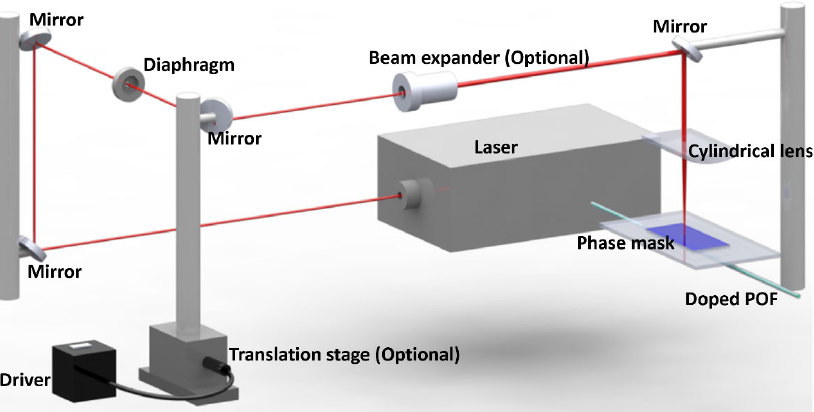
Figure 12. The diagram of inscription system based on laser and phase mask technique.